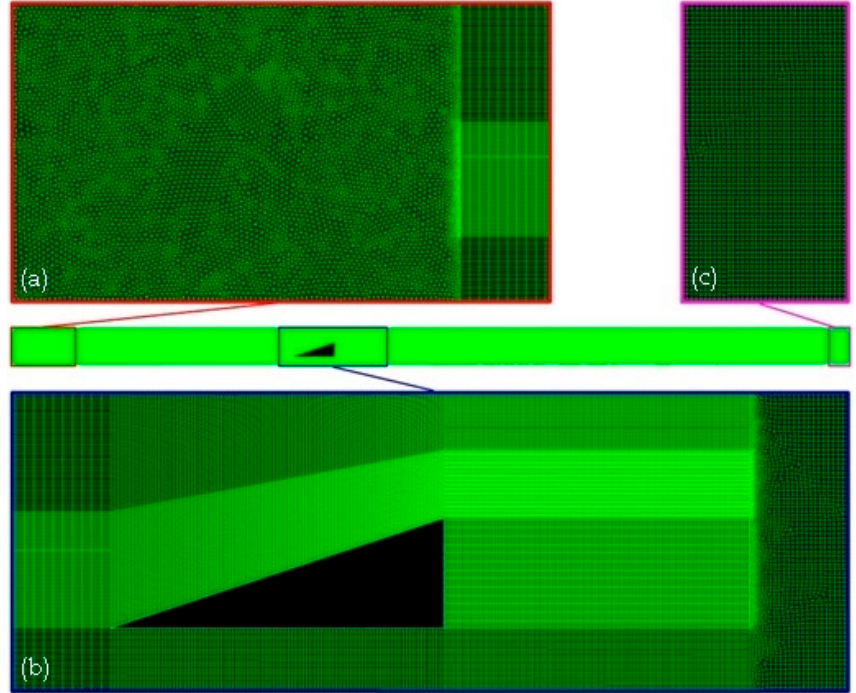
Figure 7. Mesh used, detailing the regions ( a ) R1; ( b ) R2; and ( c ) R3. As for the temporal discretization, for the representative regular and realistic irregular waves, a time step of ∆𝑡 = 0.05 s was adopted, following the indication from Liu et al. [43] for regular waves and Machado et al. [18] for irregular waves. A total time of 600 s of wave propagation was simulated. Concerning the initial condition, it was assumed that water and air were at rest, while the water depth at the beginning of the wave channel in each case was adopted as being equal to the wave height of the correspondent representative regular wave (see Table 2). It should be noted that a particularity for applying the WaveMIMO [18] is to subdivide the segment, where the prescribed velocity boundary condition is imposed into smaller segments, 1 m long, as indicated in Machado et al. [26]. Figure 8 illustrates the wave channel inlet region of Figure 5. Figure 8. Imposition region of the prescribed velocity boundary conditions for wave generation through discrete transient data [26]. 4. Results The verification and validation of the WaveMIMO methodology were carried out in Machado et al. [18] and Maciel et al. [38]. Therefore, for the sake of brevity, the verification of the numerical model used in the generation of waves will not be showed in the present